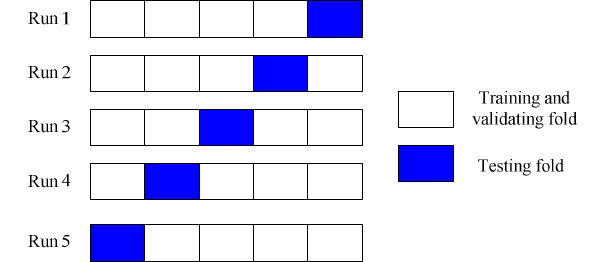
Fig. 4. Illustration of 5-fold cross